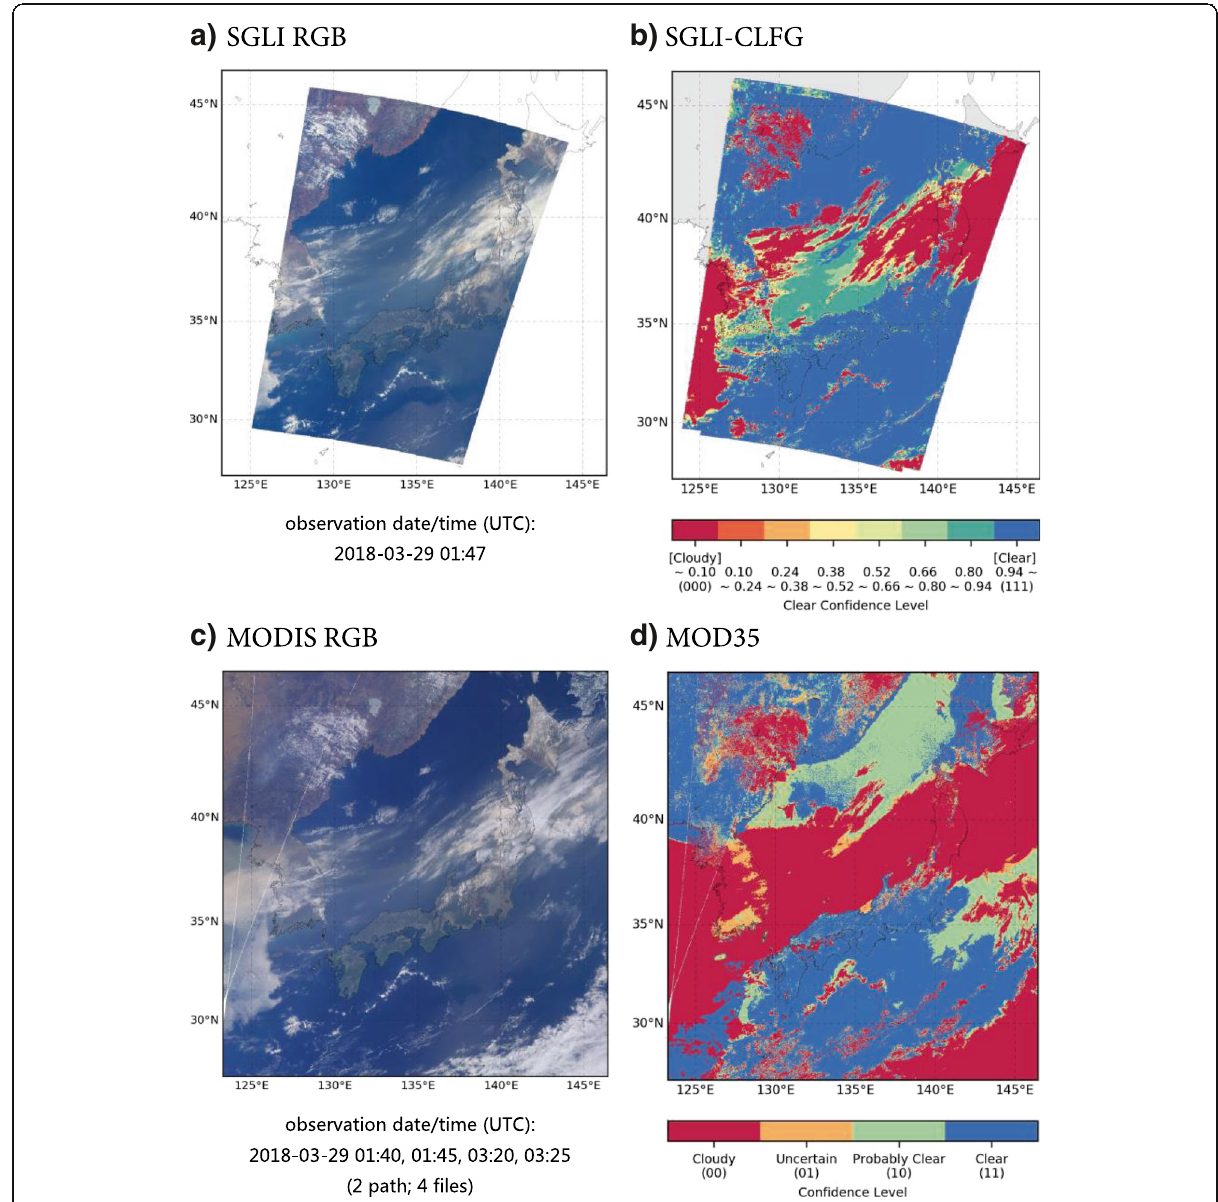
Fig. 13 Same as Fig. 12, but over Japan on March 29,